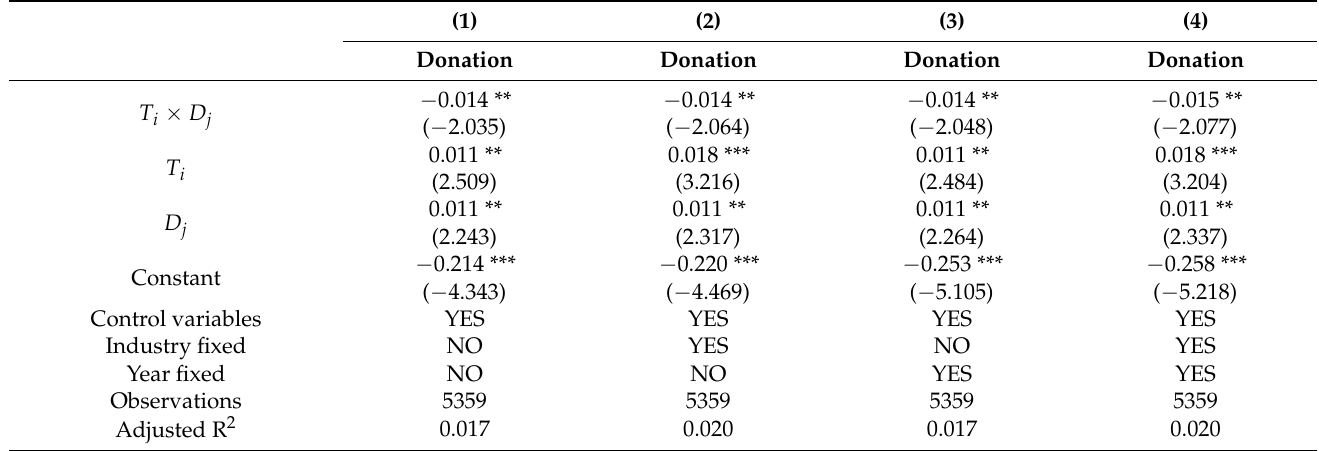
Table 4. Baseline regression